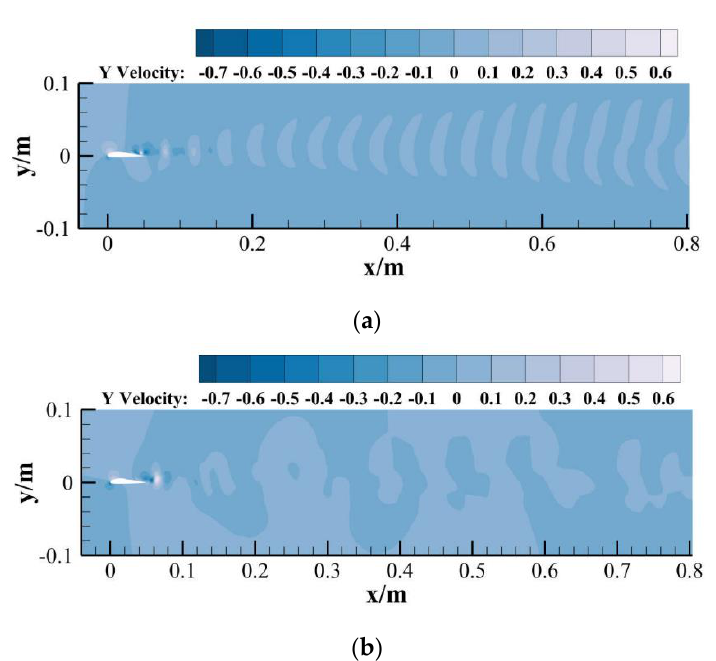
Figure 23. Comparison of the contours of instantaneous velocity in the y direction at 2.0 s between the two models: ( a ) the original hydrofoil and ( b ) the biomimetic hydrofoil.